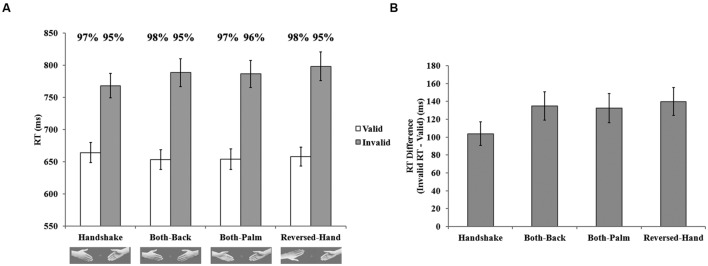
Results of Experiment 1. (A) Mean reaction time (RT) varied as a function of hand-approach display and cue validity. Mean accuracy rates for every condition was shown above the corresponding bars. (B) The mean RT difference between invalid and valid trials varied according to the hand-approach display. Error bars indicate standard errors.